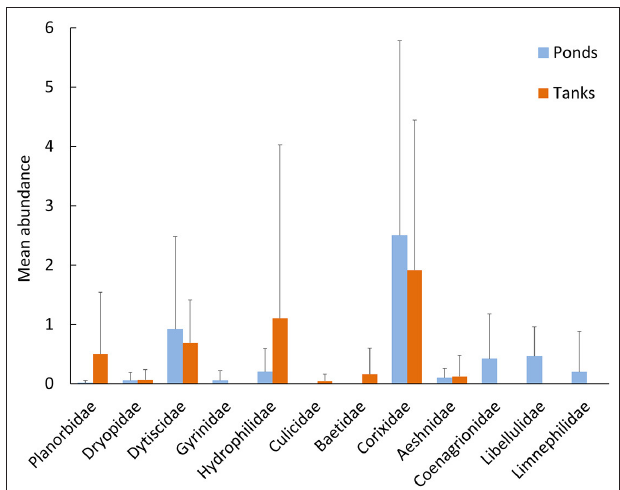
FIGURE 4 | Average number of individuals at the Family taxonomic level captured in the ponds (light blue) and tanks (dark orange) (Mean ± SD) across the extensive sampling ( n = 12 ponds, n = 8 tanks).